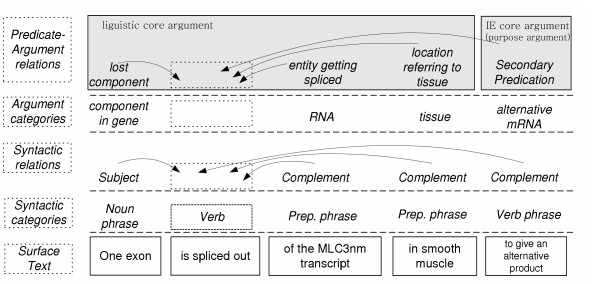
Syntactic and semantic level description of the surface text. The understanding makes on the surface text can be shown in different levels. Syntactic categories level gives a syntactical class for each constituent of the sentence. Syntactic relations level describes syntactical function of each constituent of the sentence to predicate of the sentence. Argument categories level offers the semantic concept for each constituent of the sentence. Predicate-argument relation level helps in understanding the semantic role played by each constituent or argument related to its predicate.